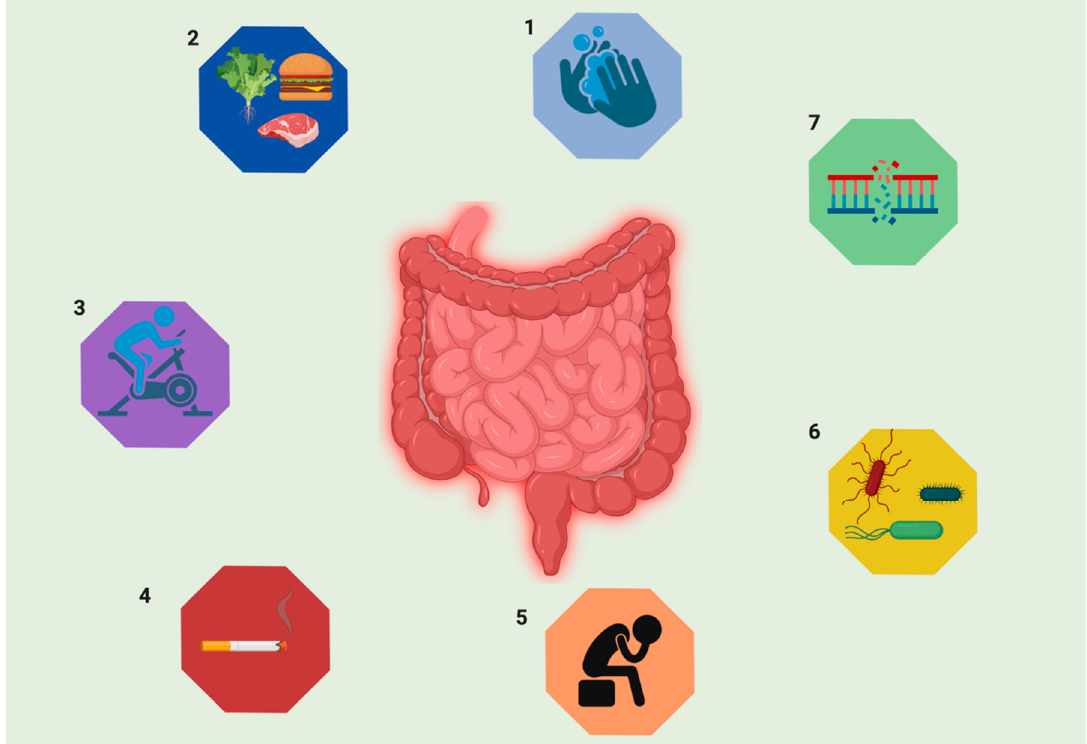
Figure 1. The chronic inflammation of the intestines in inflammatory bowel disease (IBD) can be caused by various factors including environmental triggers that can be classified into five major causes: (1) poor basic hygiene, (2) unbalanced dietary intake, (3) lack of physical exercise, (4) increased smoking (in the case of Crohn’s disease), and (5) stress. The internal factors include (6) gut microbiota dysbiosis in the intestine and (7) unpredictable genetic modification. Image developed using Biorender.com.